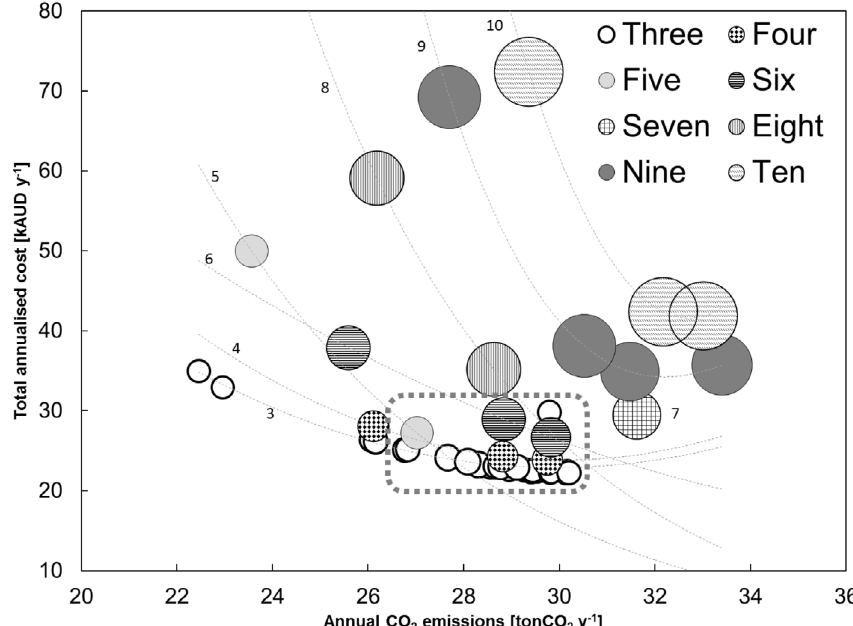
Fig. 4. Bubble chart of three objective trade-off. Cost and emissions are indicated on axes and the size of the bubbles indicates the number of nines of the average house electrical system availability. Dotted lines, iso-availability curves and are numbered with the number of nines of availability from 3 to 10